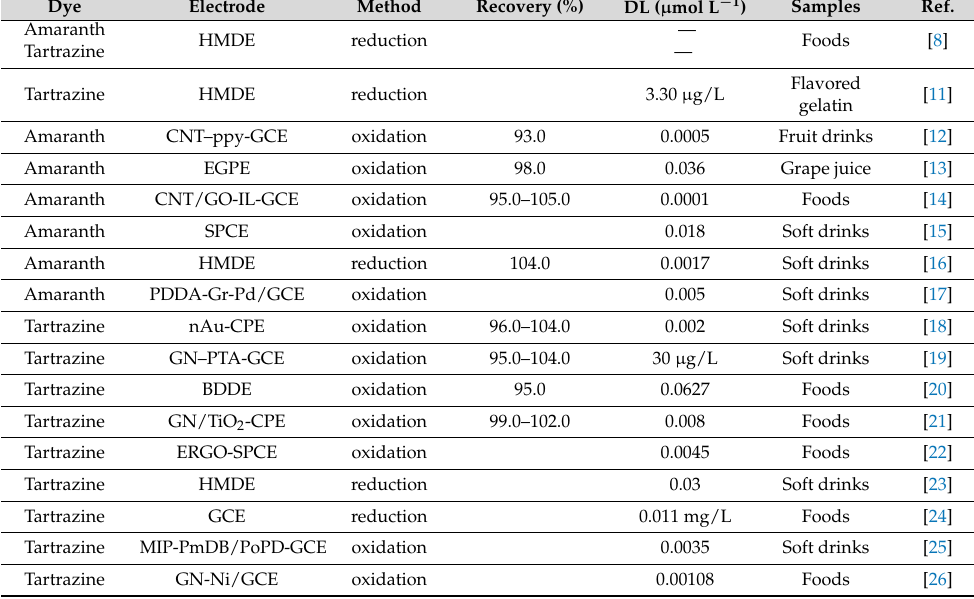
Table 1. Electroanalytical methods for AM and/or